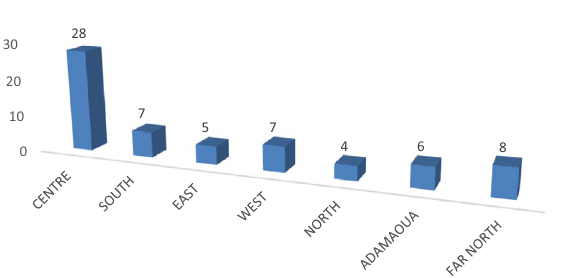
Figure 1. Distribution of participants in the CD4 EQA programming within